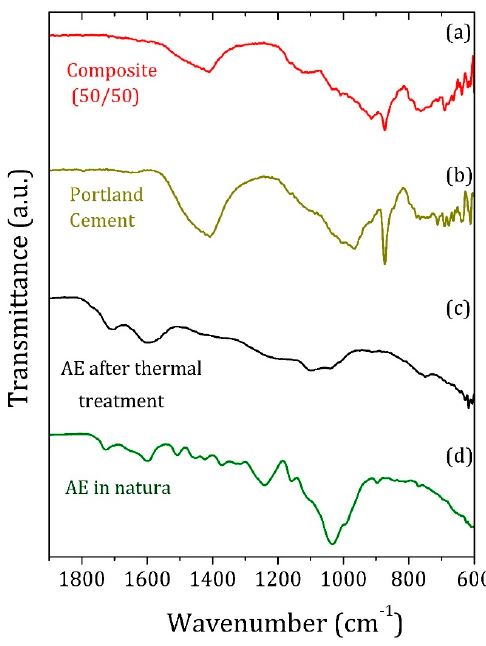
Figure 4. Infrared spectra of the ( a ) PC / AE composite with 50 wt% AE and ( b ) PC sample, both after 28 d of cure, ( c ) AE particles after thermal treatment at 250 °C, and ( d ) AE in natura.